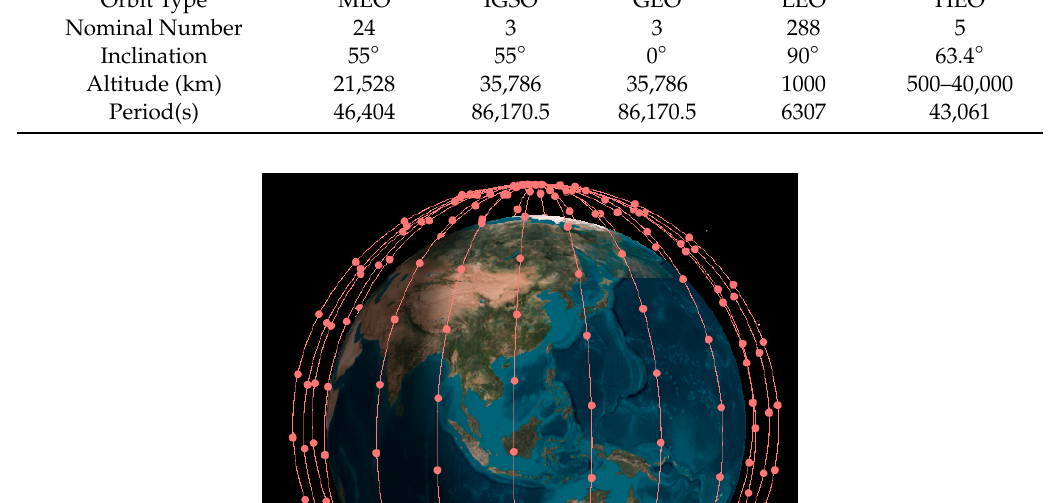
Figure 10. Low earth orbit ( LEO) satellites in the 3D graphic view. Table 8. Parameters of the BDS-3+ low earth orbit (LEO)+HEO constellation.